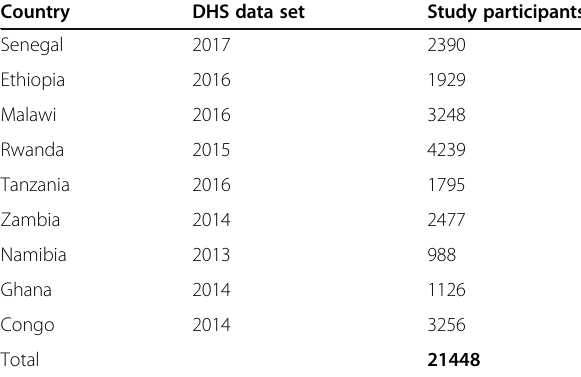
Table 1 The DHS years of study and the number of study participants in the 9 sub-Saharan Africa using Demographic and Health Surveys 2013 – 2017 Country DHS data set Study